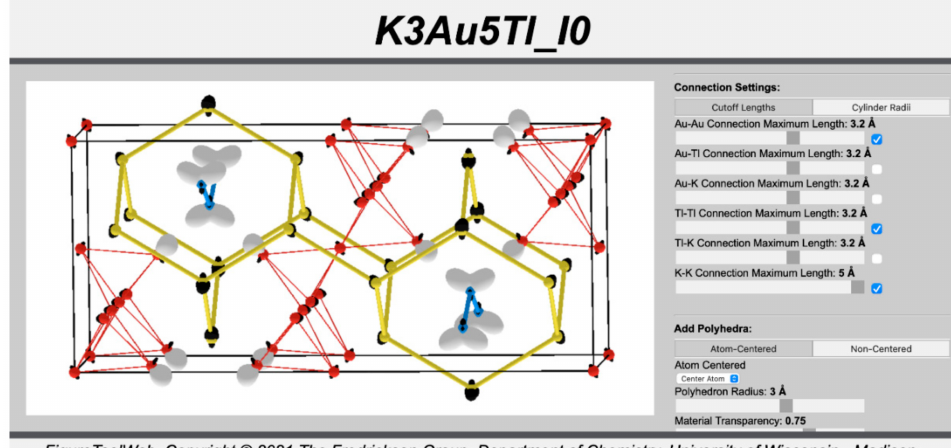
Figure 7. FigureToolWeb rendition of the CP scheme after adjustments to the CONNECTION SETTINGS